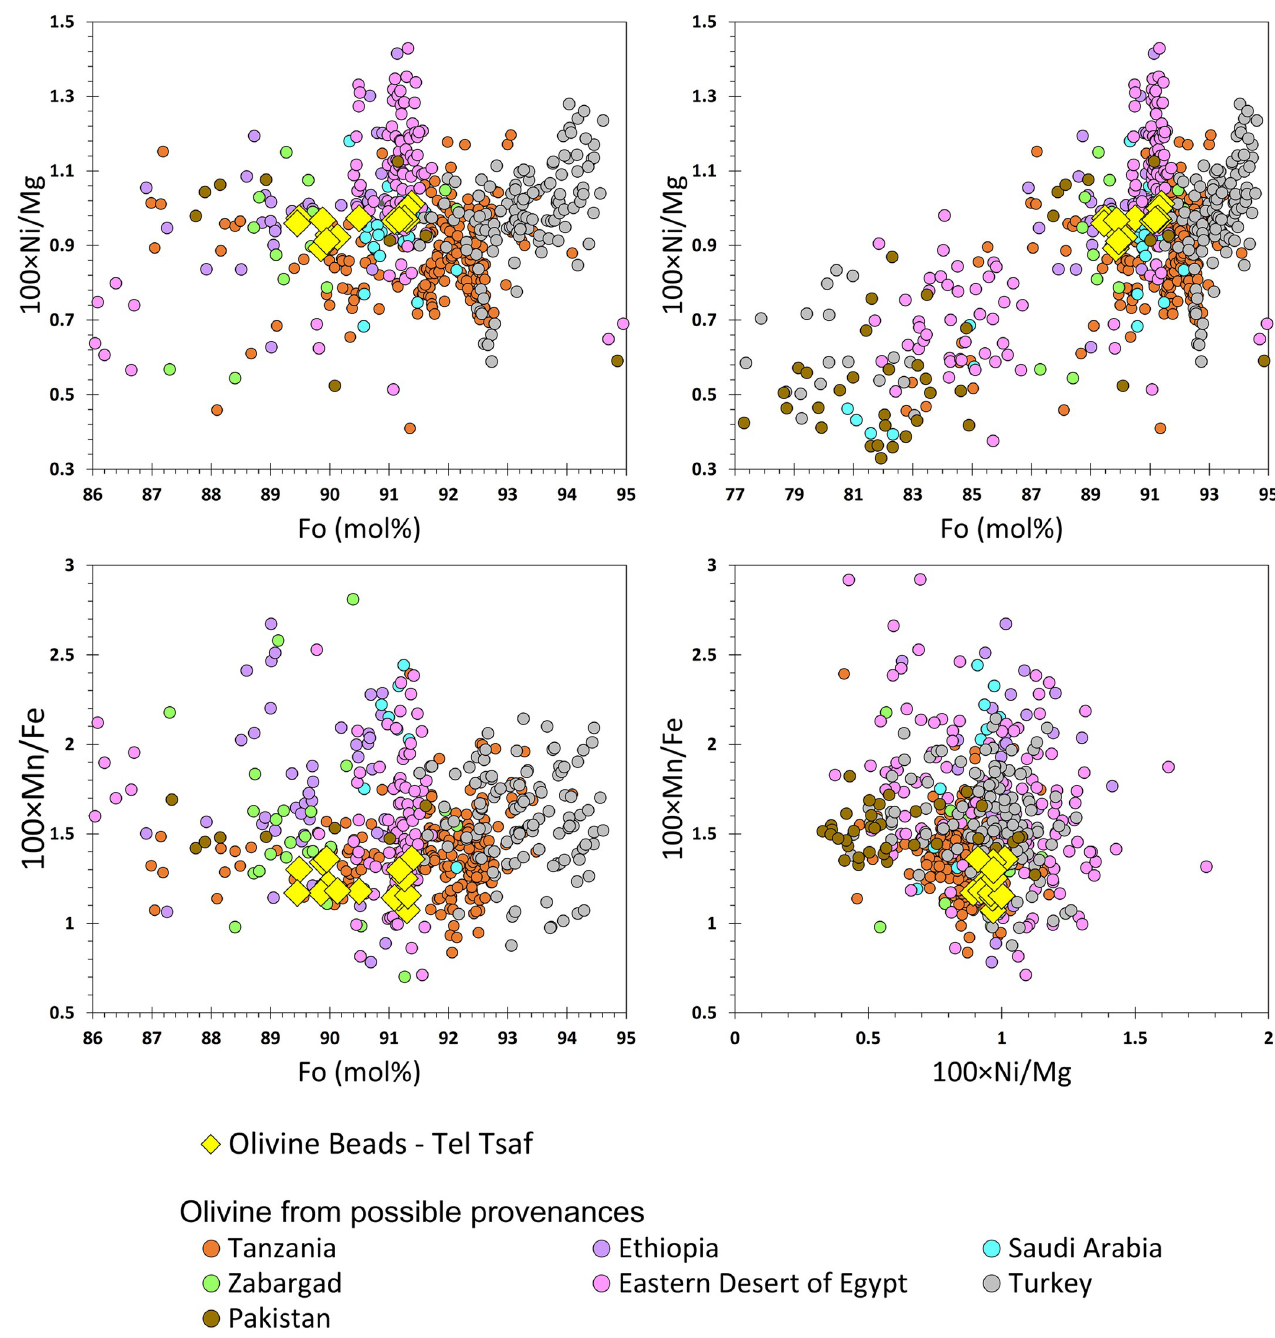
Fig 6. Chemical features of the Tel Tsaf olivine beads and possible olivine sources. (a) 100 × Ni/Mg against Fo# spanning 86%–95%; (b) 100 × Ni/Mg against Fo# spanning 77%–95%; (c) 100 × Mn/Fe against Fo# spanning 86%–95%; (d) 100 × Ni/Mg against 100 × Mn/Fe. The data for the possible olivine origins were acquired from the following sources: For Turkey [29–31], for Pakistan [32–34], for Eastern Desert of Egypt [24], for Zabargad Island [21–23], for Saudi Arabia [25–28],for Ethiopia [35–37], and for Tanzania [38–40]. Several samples are not presented here; they include specimens from the Eastern Desert of Egypt with Fo > 97% and Ni < 2000 ppm and a few specimens from Turkey and Pakistan with Fo = 100.